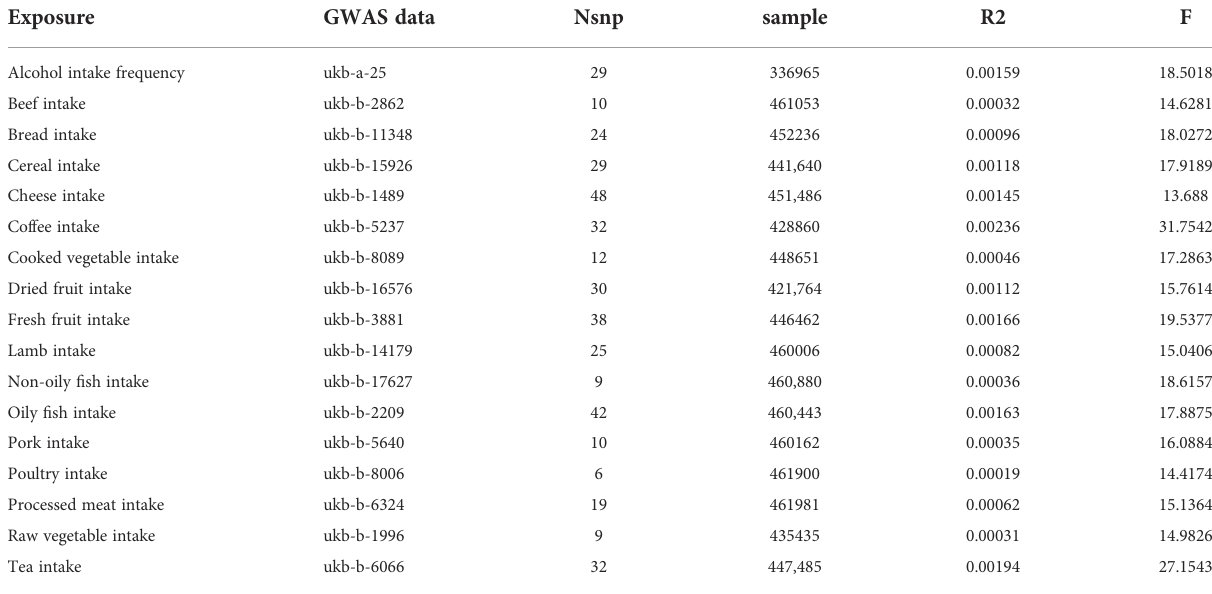
TABLE 1 Summary of modi fi able risk factors for CD.